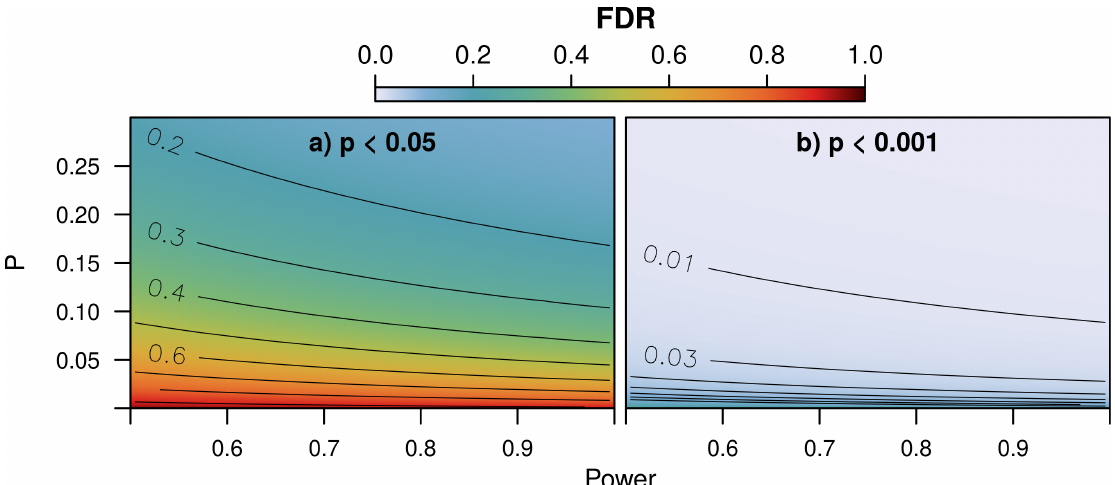
Figure 6. FDR depending on the Power of the applied test and the trend prevalence ( P ) under real conditions for ( a ) “significant” trends ( p < 0.05); and ( b ) “conclusive” trends ( p <